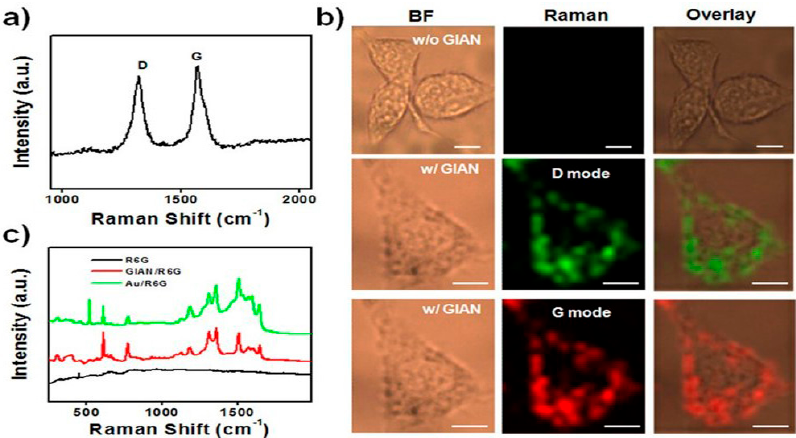
Figure 15. ( a ) Raman spectrum (excitation at 632 nm) of GIANs showing the G and D bands of graphitic carbon; ( b ) Raman imaging of MCF-7 cells with and without GIAN staining. BF: bright field, scale bar: 10 μ m; ( c ) Raman spectra of R6G molecules, with and without GIAN, and with AuNPs, respectively. The figures are adapted from [138], with permission from ©2014 Nature Publishing Group.